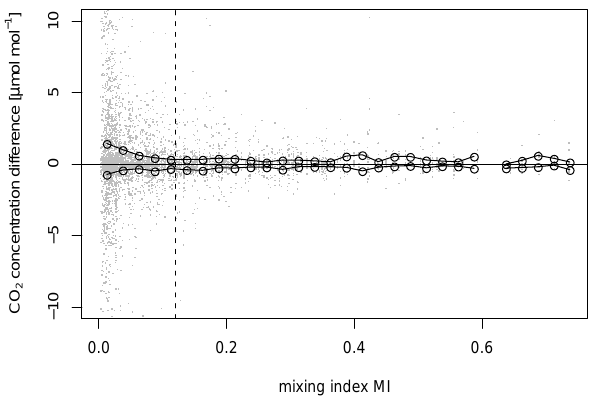
Fig. 10. Modes of 60-minute density distributions of concentration differences c i ( t ) − ˜ c minus analyzer drift ( mode of 24 hour pdf of 60-minute modes subtracted daily) versus mixing index MI. Grey points indicate measurements, the solid line marks the 25% and 75% quantiles for mixing index binwidths of 0.025 with the circles centered at each bin. Dashed line at MI=0.12 indicates a sensible choice for the critical mixing index MI c .